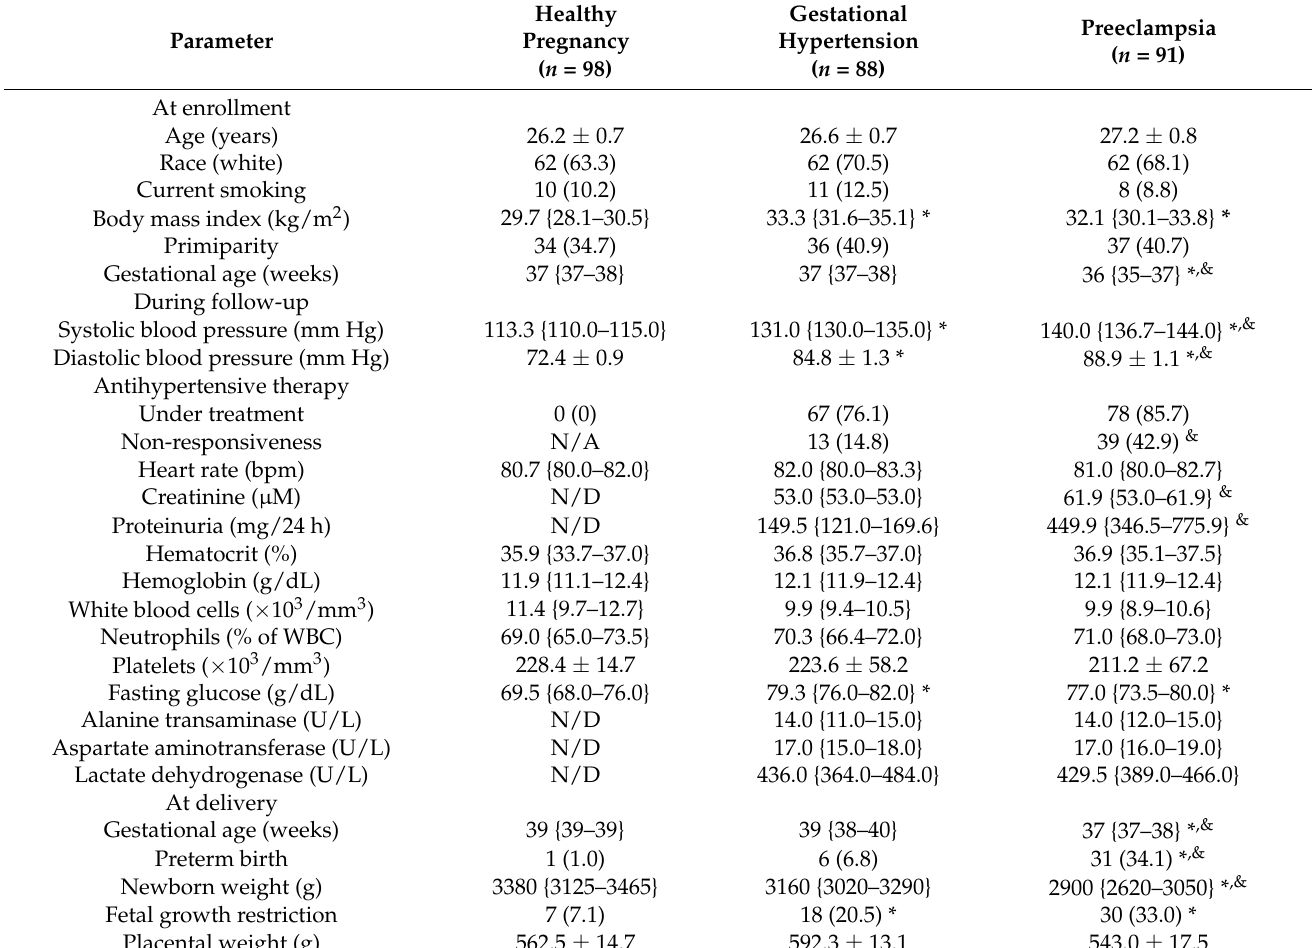
Table 1. Demographic and clinical characteristics of study